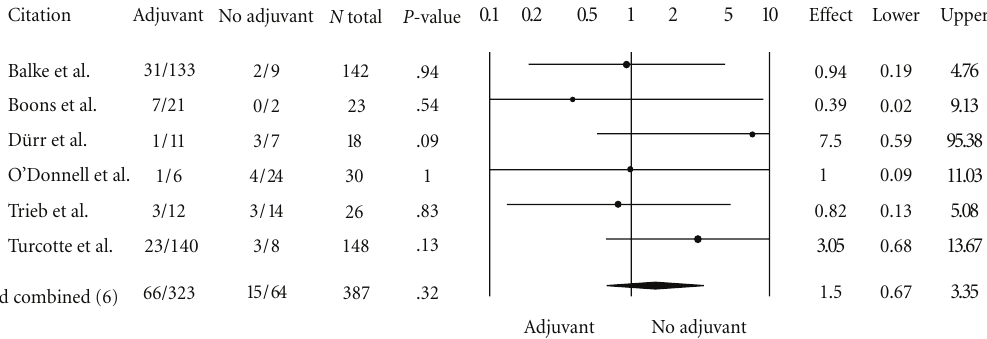
Figure 2: Forest plot for odds ratios of overall recurrence by type of intervention (95% CI, 0.67–3.35, P = .